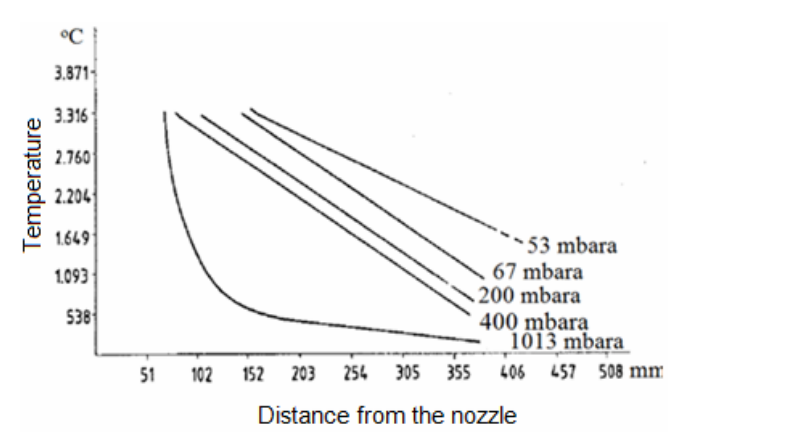
Figure 8 – Effect of operating pressure on the temperature of plasma jets Slika 8 – Uticaj radnog pritiska na temperature mlazeva plazmi Рис . 8 – Воздействие давления на температуру плазменной струи